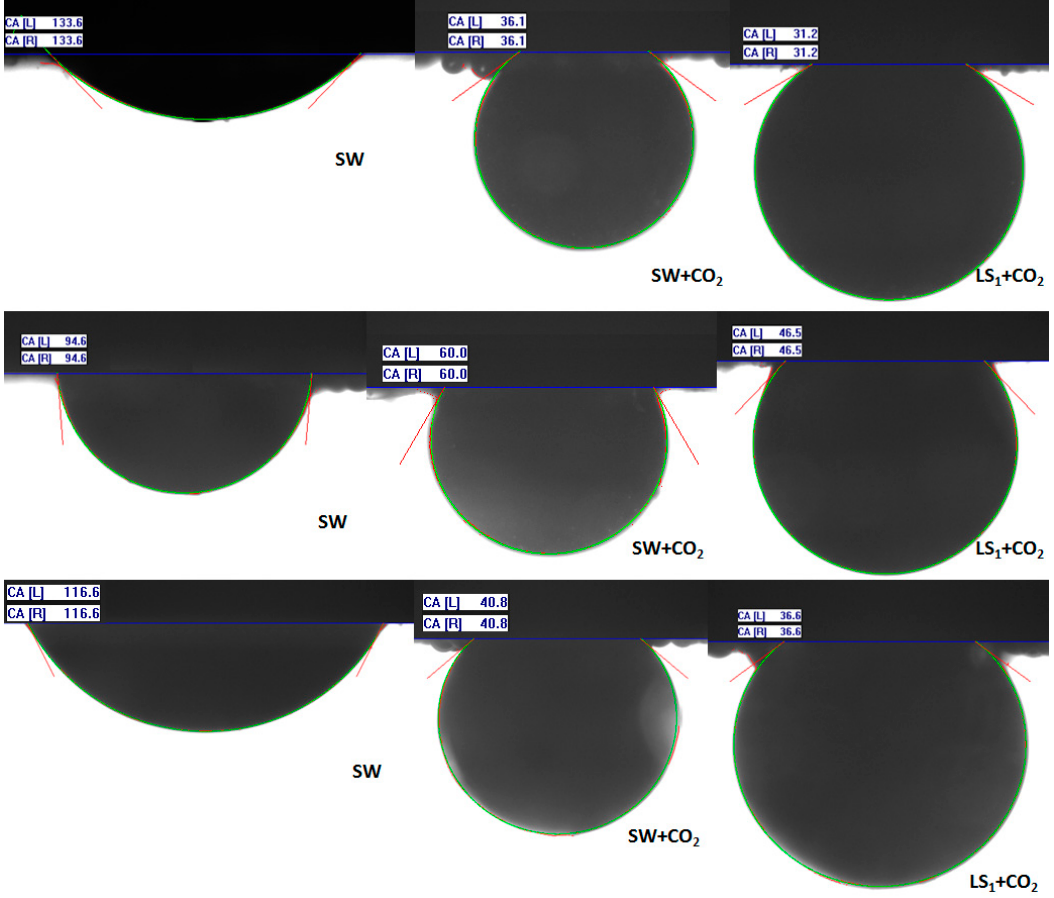
Figure 3. Contact angle of carbonate (top row), sandstone (middle row), shale (bottom row) core samples after they were soaked in seawater (SW), carbonated seawater (SW+CO 2 ), and carbonated low salinity water (LS 1 +CO 2 ). The volume of oil droplets ranges from 4 to 15 µL [11].